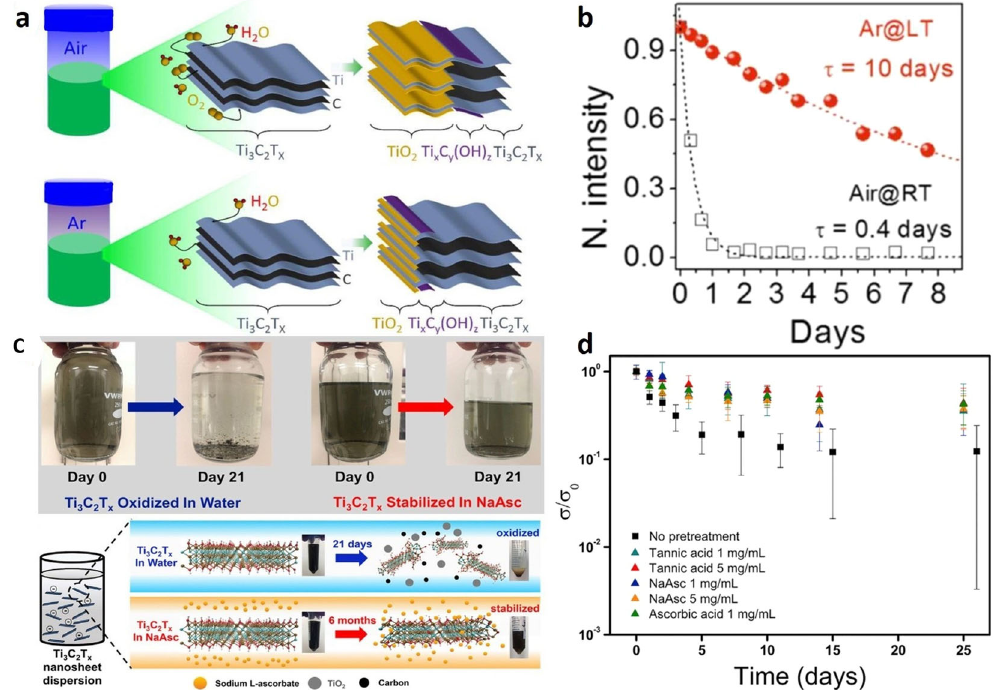
Fig. 13 Shelf stability of colloidal MXenes. a Schematic diagram of colloidal d-Ti 3 C 2 T x MXene aqueous solution degradation in the air and argon at room temperature denoted as Air@RT and Ar@RT. b The d-Ti 2 C 2 T x stability in Air@RT and Ar@LT. a , b reprinted with permission from 157 Chemistry of Materials 2017, 29, 4848-4856; Publication Date: May 09, (2017) https://doi.org/10.1021/acs.chemmater.7b00745 Copyright (2017) American Chemical Society; c Shelf-stable Ti 3 C 2 T x NSs stabilized by sodium L -ascorbate (NaAsc) solution and stored in deionized water. Ti 3 C 2 T x oxidizes and degrades without antioxidants to form TiO 2 and carbon. Sodium L-ascorbate protects against seriously oxidizing the nanosheet; d Conductivity shift vs . time of Ti 3 C 2 T x Buckypaper produced after pretreatment with selected antioxidants. c , d used with permission from Elsevier B.V./Zhao 158